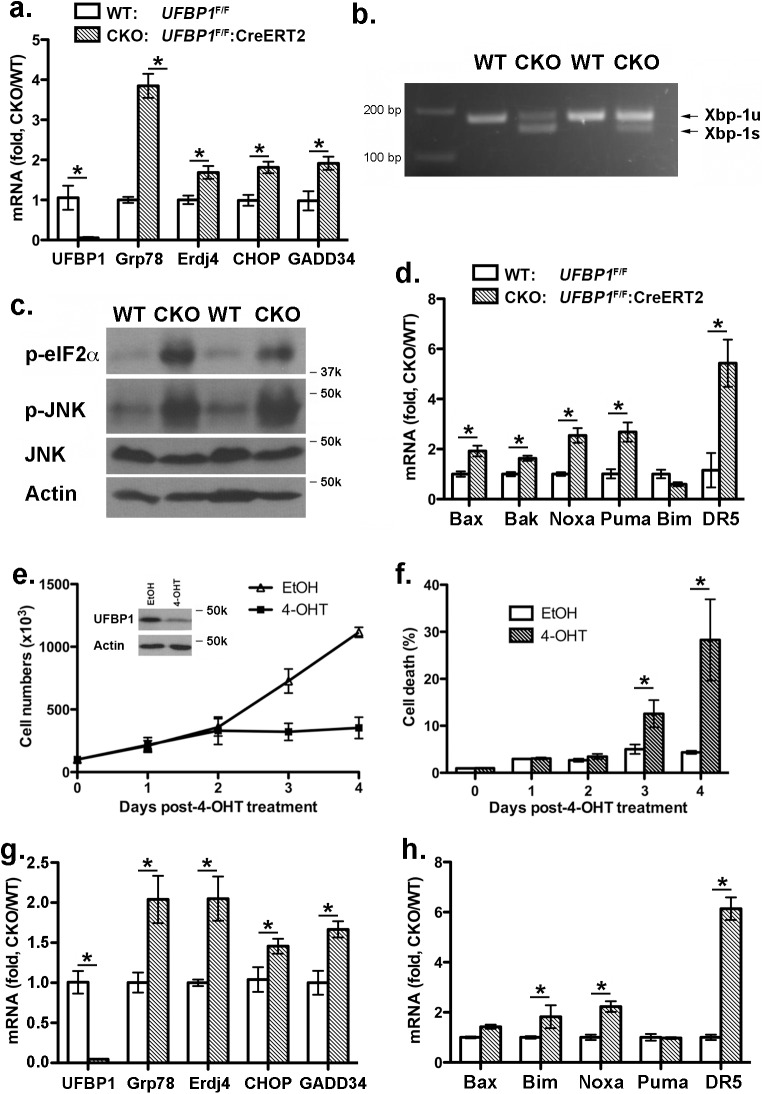
Loss of UFBP1 activates the UPR and cell death program.
a. Up-regulation of Grp78, ERdj4 and CHOP in UFBP1 deficient BM cells. Total RNAs were purified from BM cells and subject to quantitative RT-PCR analysis (normalized to β-actin gene). TAM-injected UFBP1
F/Fmice were used as WT control mice, while TAM-injected UFBP1
F/F:CreERT2 mice were designated as CKO mice. The ratio of CKO to WT was presented. * p < 0.01 (n = 3). Data are presented as means ± SD. b. Xbp-1 mRNA splicing in UFBP1 deficient BM cells. Total RNAs were isolated from BM cells of control and CKO mice, and subjected to Xbp-1 mRNA splicing assay. c. Elevation of phosphorylation of eIF2α and JNK in UFBP1 deficient cells. Total cell lysates of BM cells were subjected to immunoblotting of indicated antibodies. d. Up-regulation of cell death genes in UFBP1 deficient BM cells. Total RNAs were purified from BM cells and subject to quantitative RT-PCR analysis (normalized to β-actin gene). The ratio of CKO to WT was presented. * p < 0.01 (n = 3). e. Proliferation of wild-type and UFBP1 deficient LSK cells. LSK cells were sorted from BM of UFBP1
F/F:CreERT2 mice, and cultured in the absence or presence of 4-OHT (1 μM) for indicated period of time. Cell numbers were manually scored. The experiment was performed three times independently. f. Cell death of UFBP1 deficient HLSK cells. Cell death was elevated by DNA dye exclusion assay. g. Up-regulation of UPR genes in UFBP1 deficient LSK cells. Total RNAs were purified from LSK cells and subject to quantitative RT-PCR analysis (normalized to β-actin gene). The ratio of CKO to WT was presented. * p < 0.01 (n = 3). h. Up-regulation of cell death genes in UFBP1 deficient LSK cells. The ratio of CKO to WT was presented (normalized to β-actin gene). * p < 0.01 (n = 3).